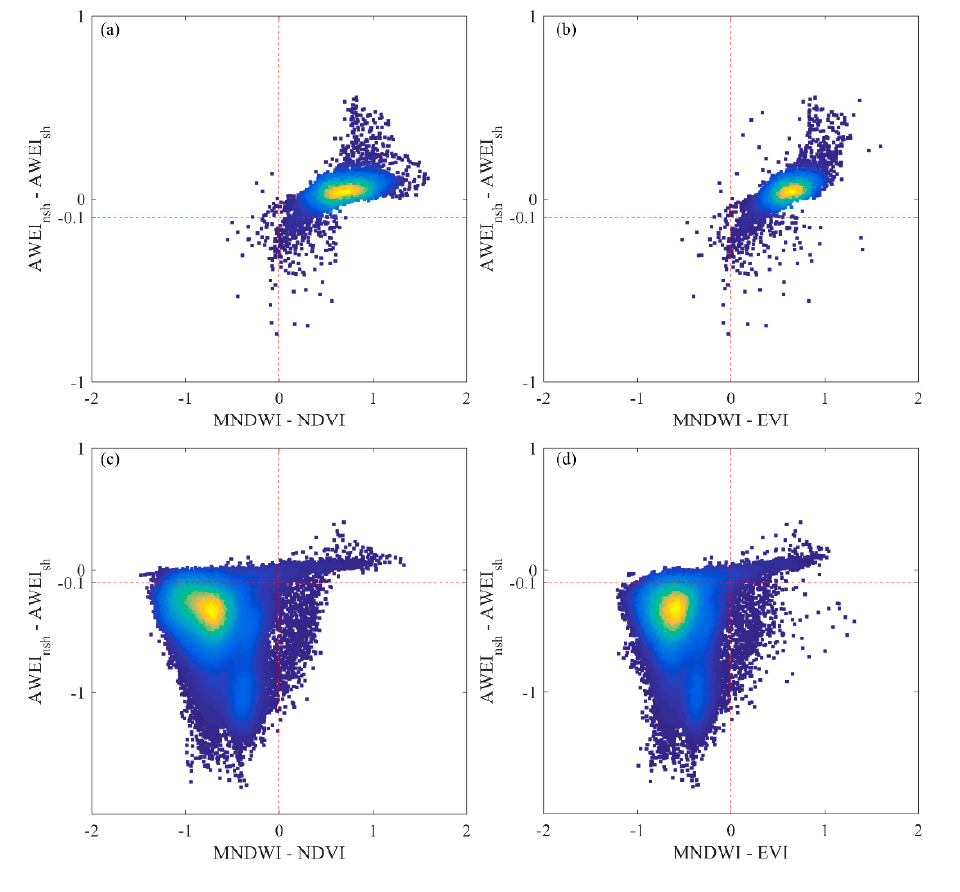
Figure 4. The scatter density of samples. ( a ) and ( b ) indicates the water samples. ( c ) and ( d ) indicates the non-water samples.